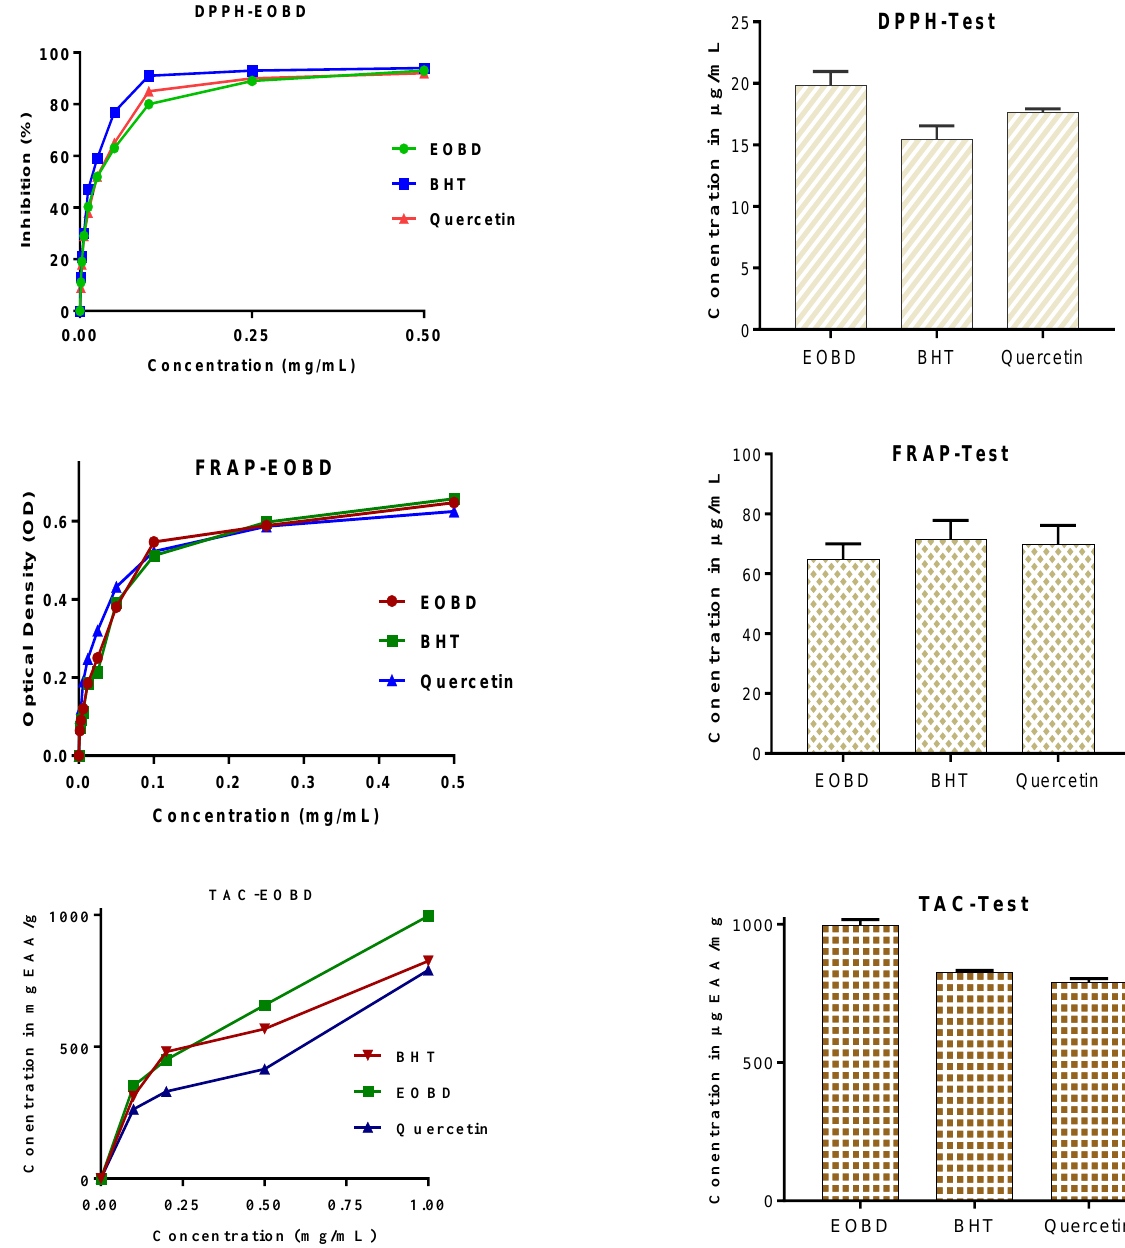
Figure 2. Antioxidant activity of EOBD, BHT and Quercetin by DPPH method, by FRAP method and total antioxidant capacity.